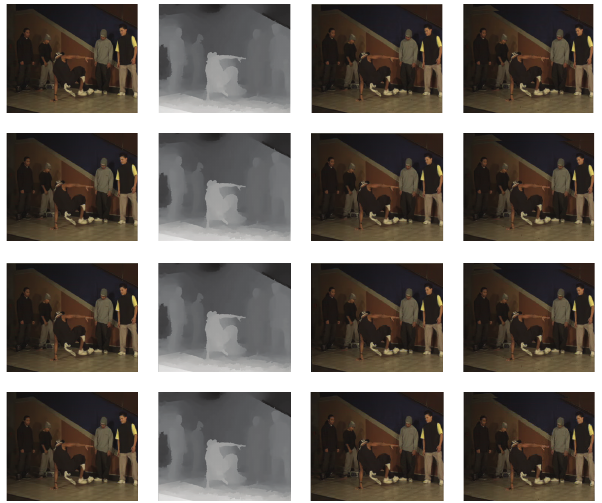
Figure 20: Image from Breakdance sequence. Left to right: color view, depth map, right view, left view. to bottom: SVC, PSS, ILPS, 3D-ILPS. All information received.